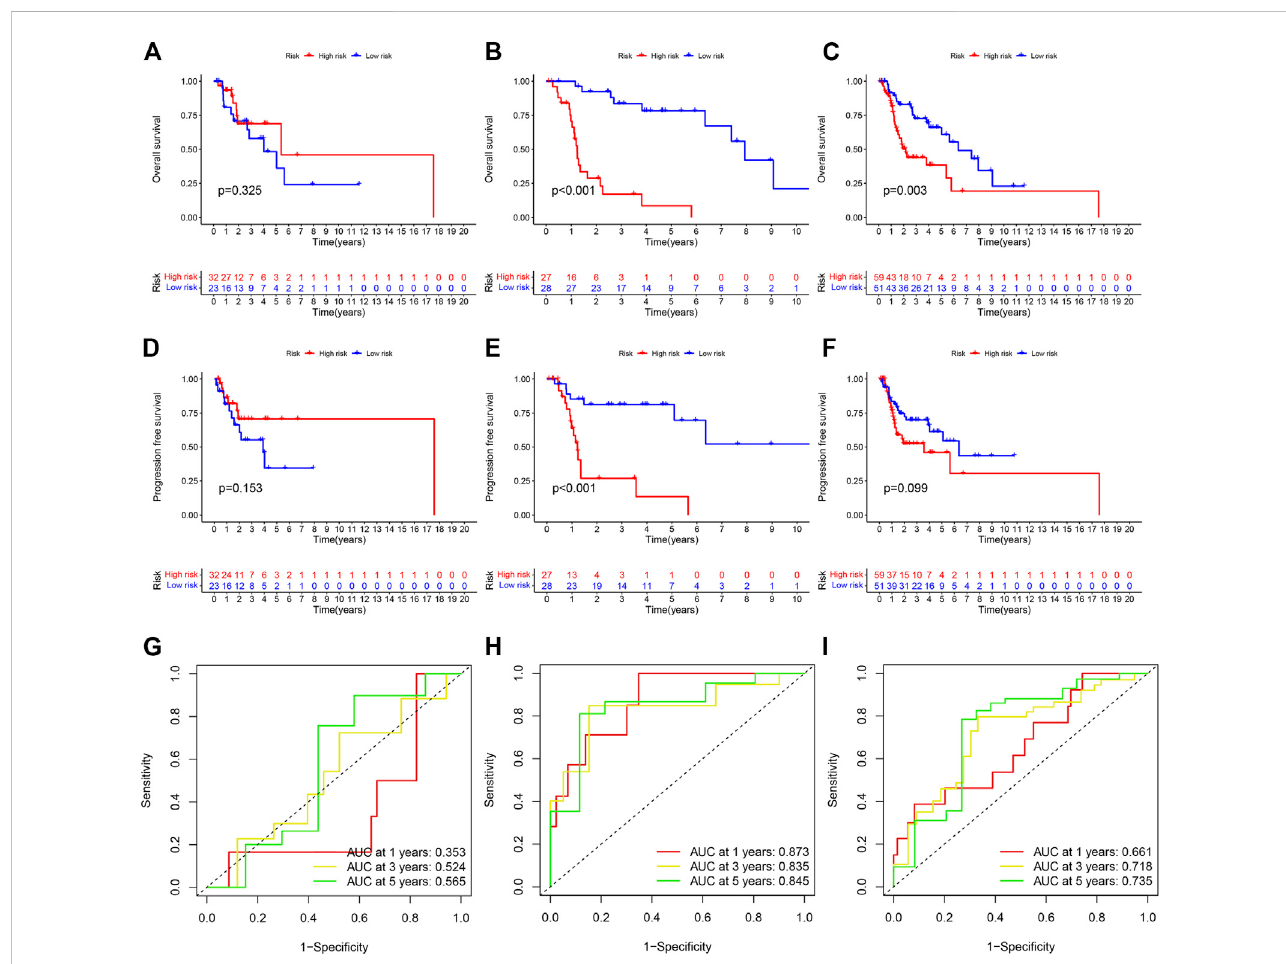
FIGURE 5 (A – C) Kaplan-Meier curve to show overall survival of patients indifferent risk groups. (A) is from the testing set; (B) is from the training set and (C) is from the entire set. (D – F) Kaplan-Meier curve to show progression-free survival of patients in in different risk groups. (D) is from the testing set; (E) is from the training set and (F) is from the entire set. (G – I) ROC curve to show the performance of CRLs risk model. (G) is from the testing set; (H) is from the training set and (I) is from the entire